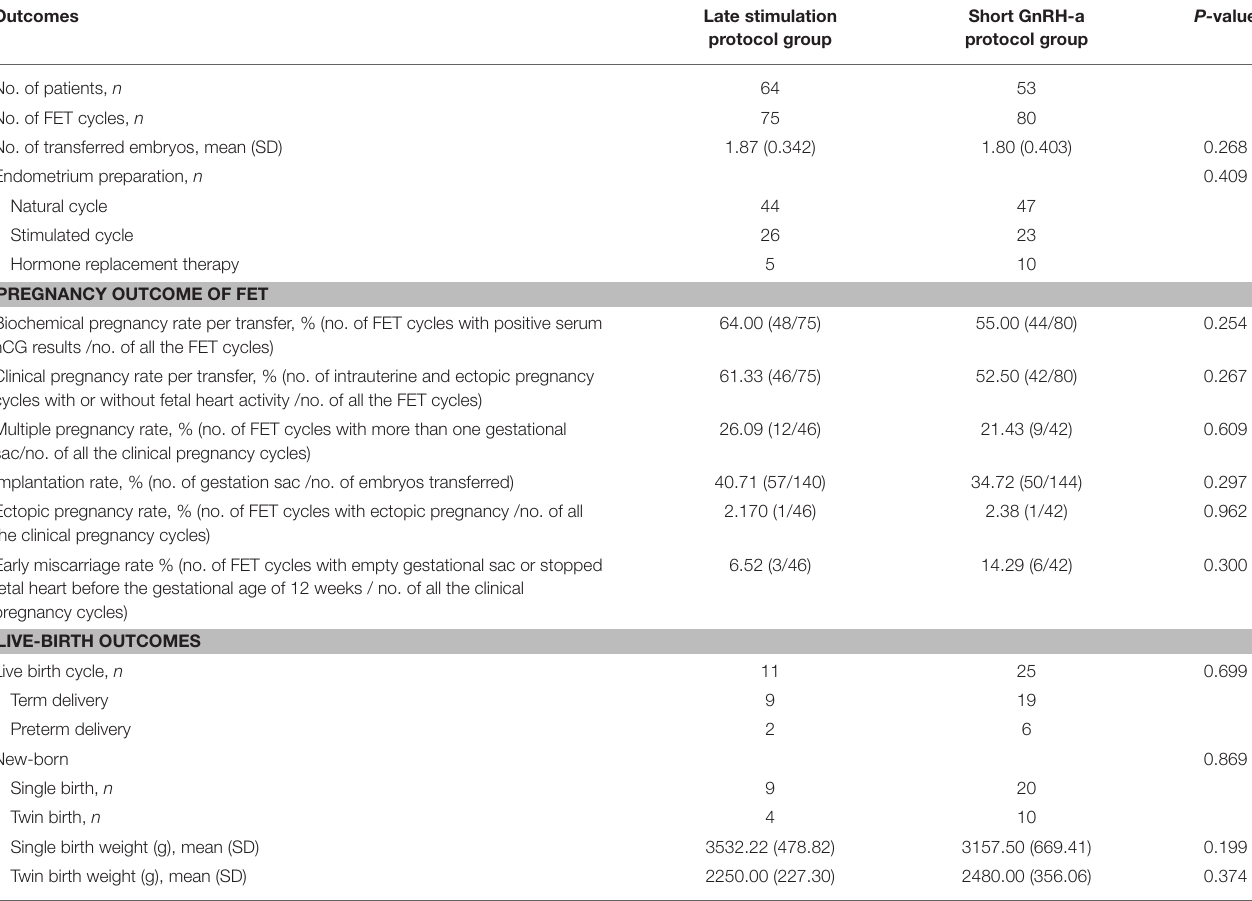
TABLE 3 | Pregnancy and live birth outcomes of frozen-thawed embryos in the two groups. Outcomes Late stimulation